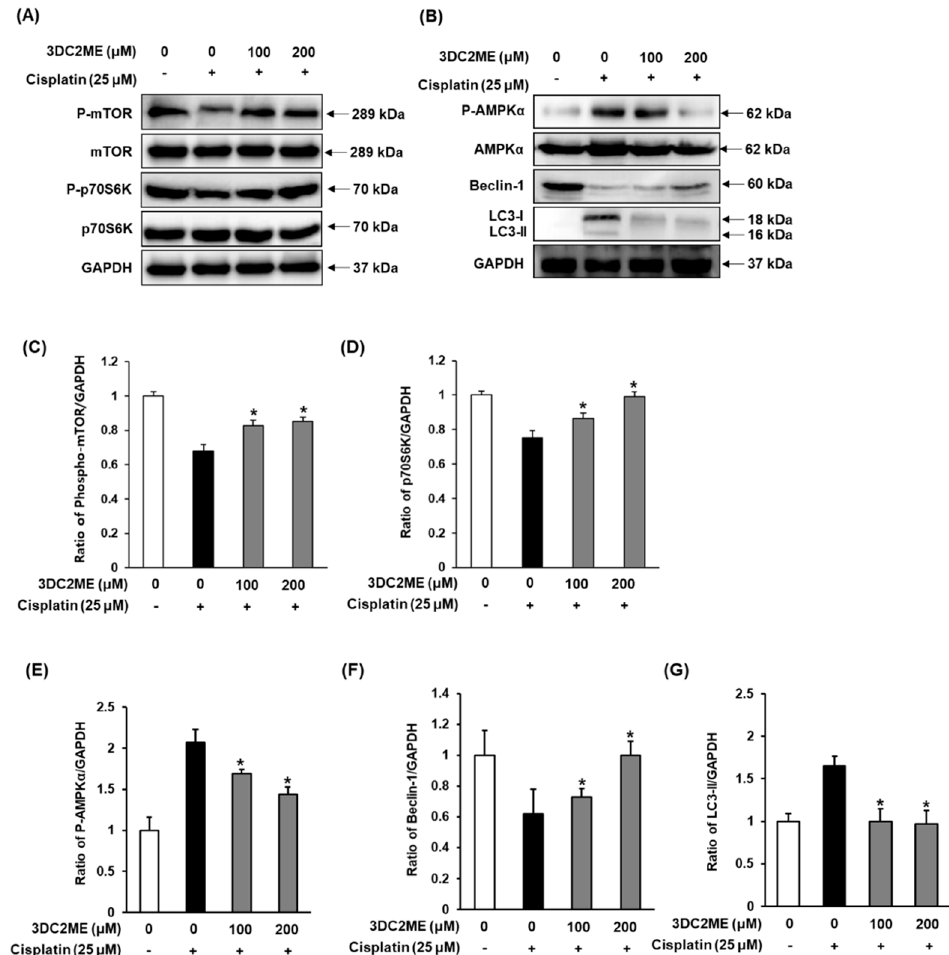
Figure 5. Effect of 3DC2ME isolated from Z. jujuba root extract on expression of ( A ) phospho-mTOR, mTOR, phospho-p70S6K, p70S6K, and ( B ) phospho-AMPK α , AMPK α , Beclin-1, and LC3 in LLC-PK1 cells exposed to 25 μ M cisplatin by western blotting. ( C – G ) Bar graphs indicated the relative ratio of the western blot band signals in each group as compared with control cells.(mean ± SD, * p < 0.05 cisplatin-treated LLC-PK1 cells). 3DC2ME, 3-dehydroxyceanothetric acid 2-methyl ester; 3-MA, 3-methyladenine; SD, standard deviation.